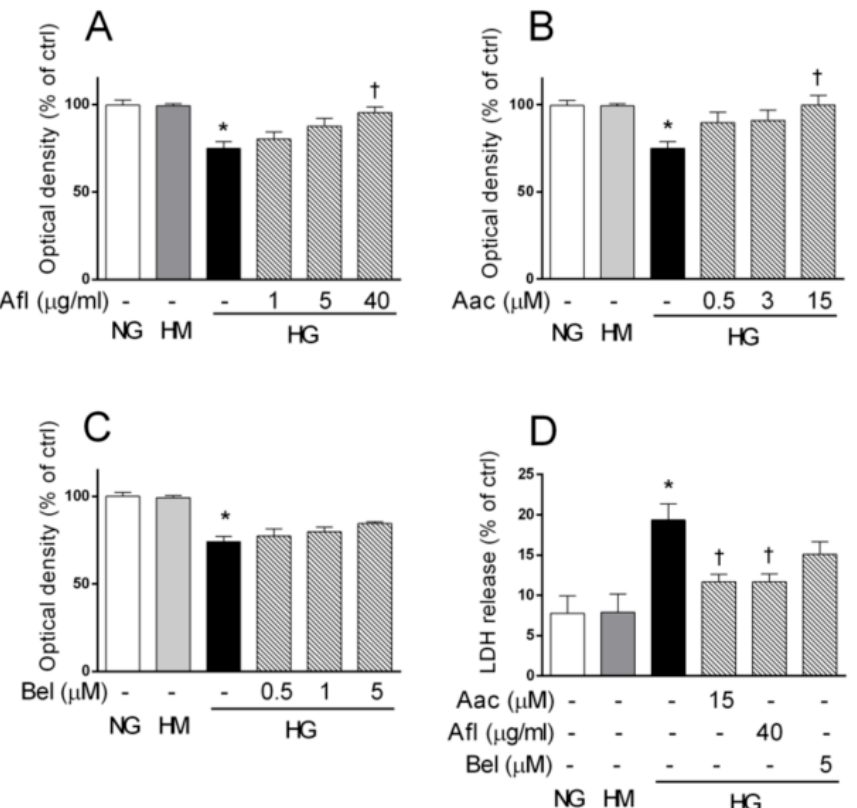
Figure 1. Aflibercept and the cPLA2 inhibitor AACOCF3 reduced cell damage in human retinal endothelial cells (HRECs) treated with high glucose (HG). HRECs were treated for 48 h with normal glucose (NG, 5 mM), high mannitol (HM, 25 mM) or high glucose (HG, 25 mM), alone or supplemented with increasing amounts of Aflibercept (Afl, 1, 5, and 40 µ g / mL), the cPLA2 inhibitor AACOCF3 (Aac, 0.5, 3, and 15 µ M) or the iPLA2 inhibitor (Bel, 0.5, 1, and 5 µ M). After the treatments, cells were assessed for viability (MTT assay, panels A – C ). Cells treated with maximal drug concentrations were also assessed in a cytotoxicity test (LDH release, panel D ). Values are expressed as a mean ± SEM of three independent experiments, each run in triplicate. * p < 0.05 vs. CTRL; † p < 0.05 vs. HG alone. One-way ANOVA, followed by Tukey’s test.